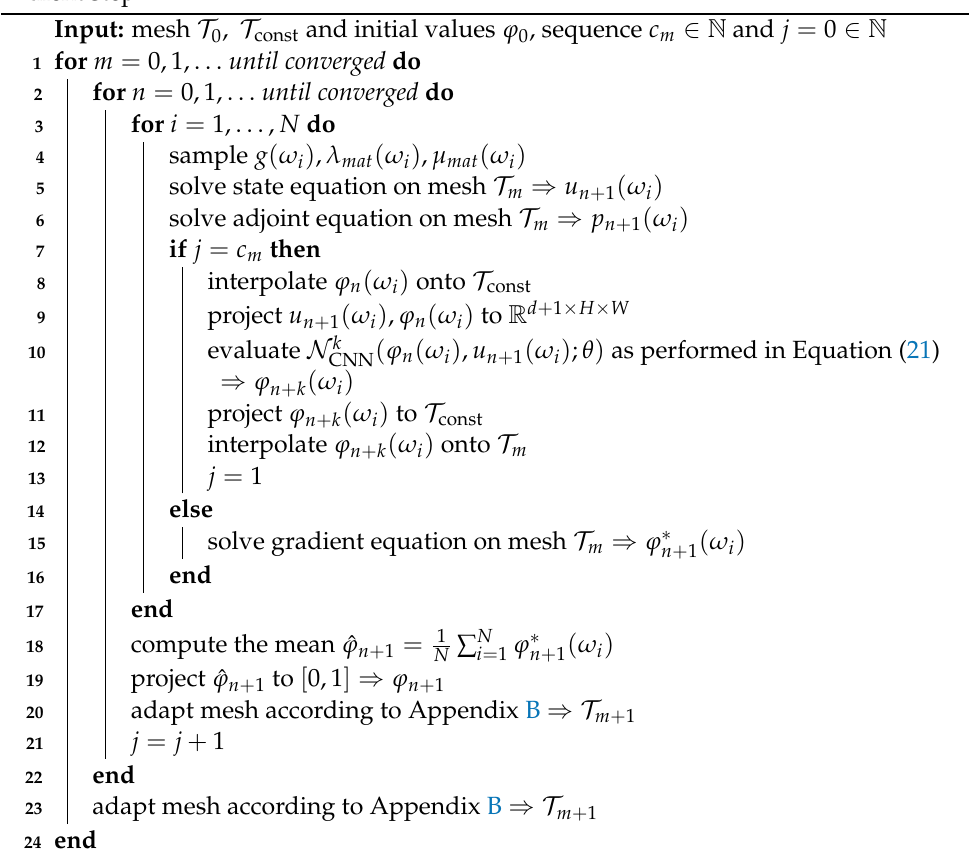
Algorithm 2: Stochastic optimisation algorithm with TCNN approximated